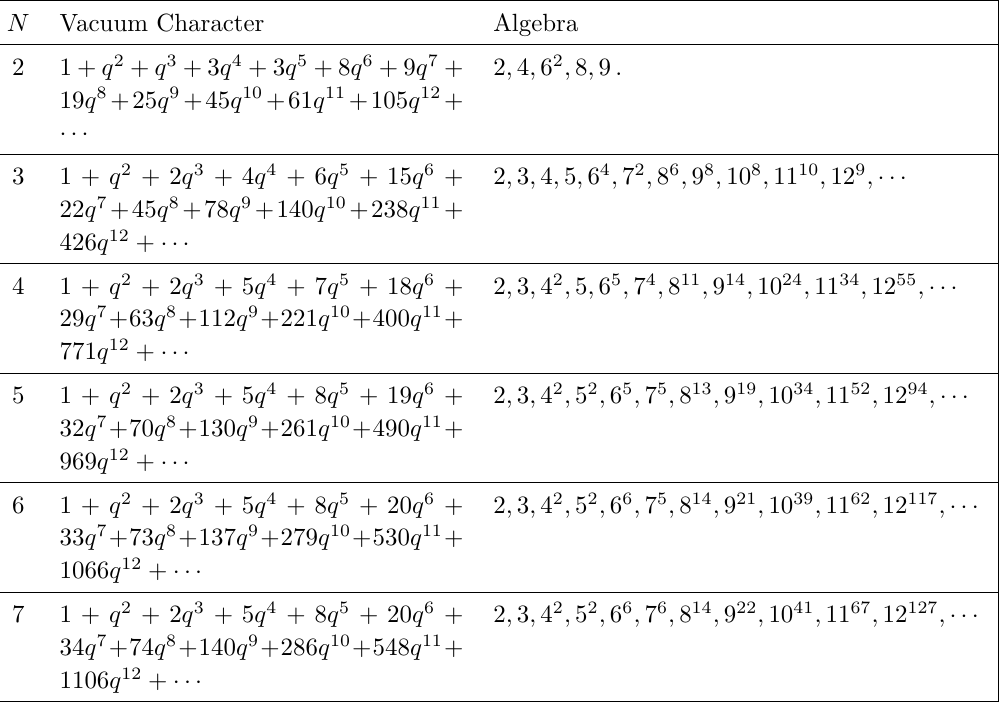
Table 2 . The vacuum character for the vector coset model for (cid:12)xed k = 3 and small values of N